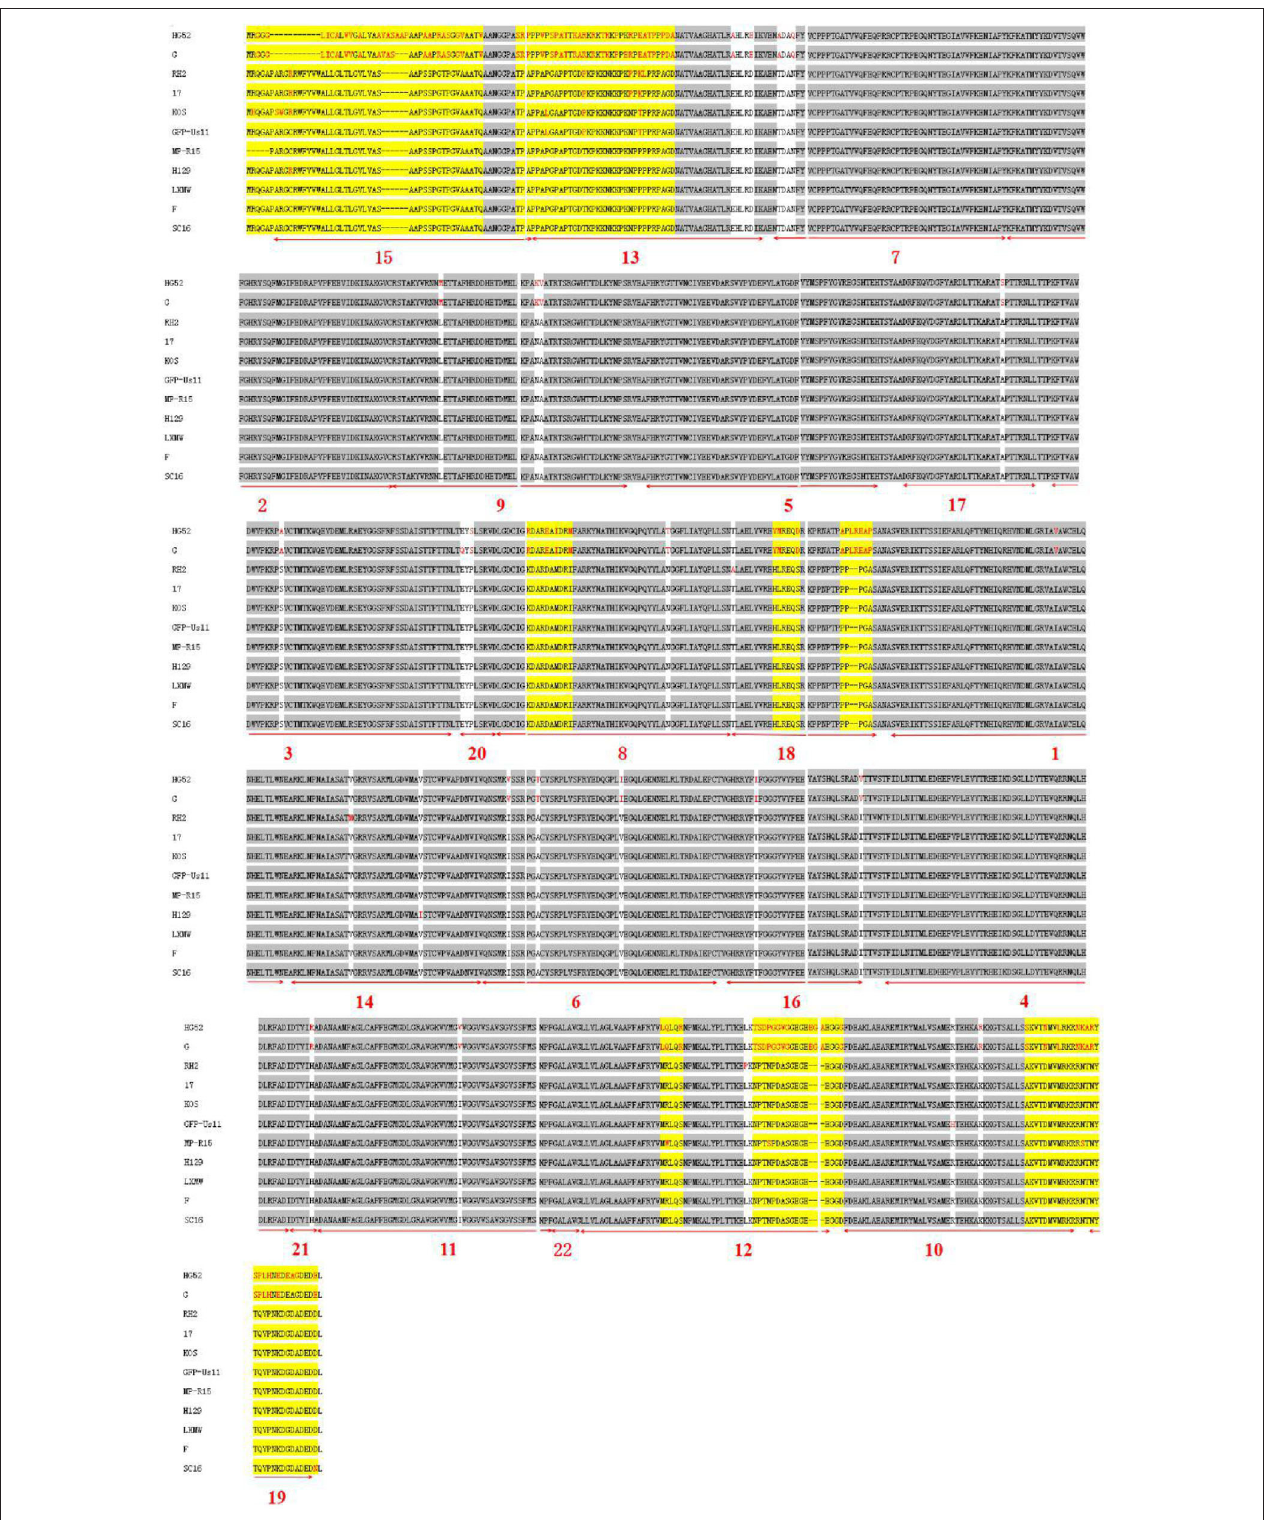
FIGURE 4 | The gB amino acid sequence alignment of 11 HSV strains.